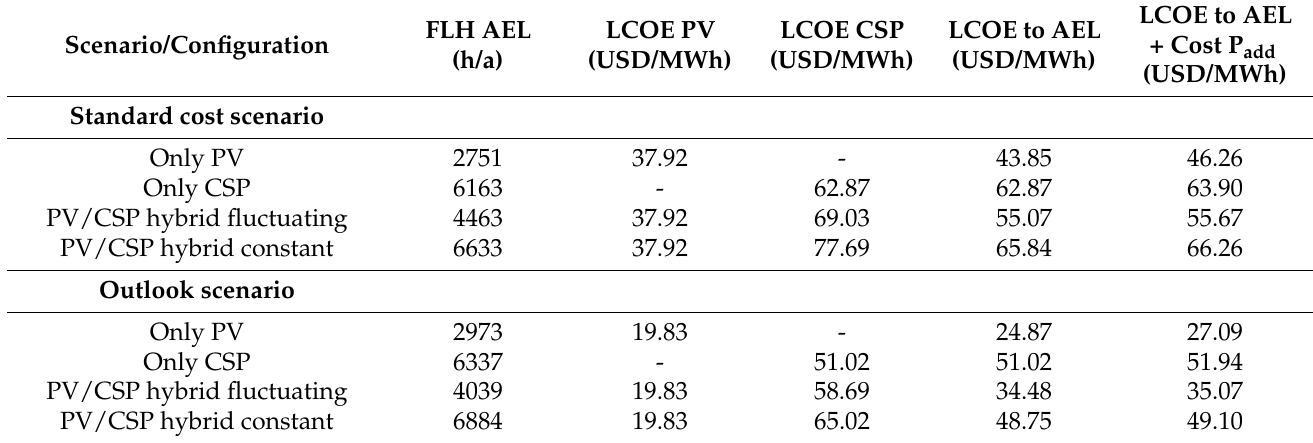
Table 9. Results of AEL-system full load hours and levelized cost of electricity (LCOE) for the most promising PV/CSP-AEL plant configurations in the standard and in the cost reduction outlook scenario. Plant location is Ouarzazate in Morocco.